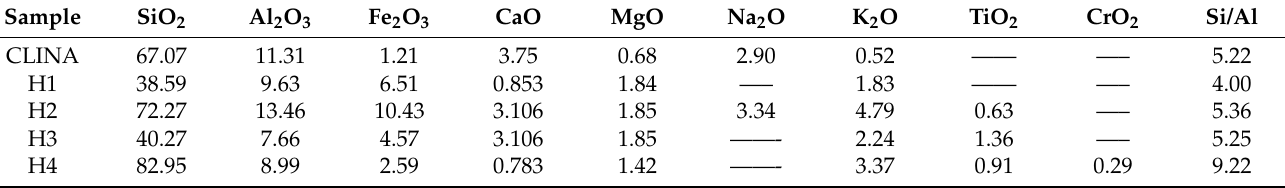
Figure 5. N 2 adsorption isotherms at 77 K on CLINA and H ‐ modified zeolites.